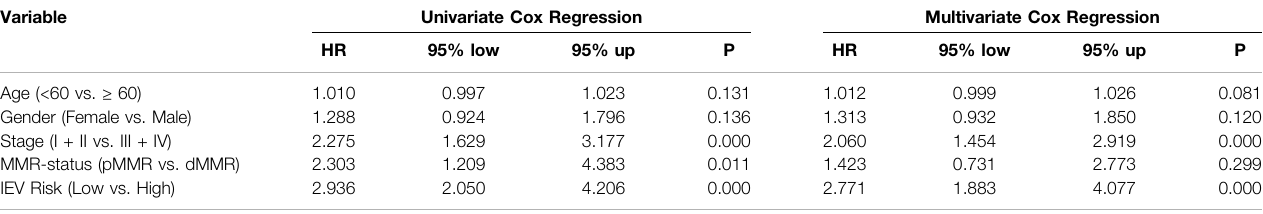
TABLE 1 | Univariate and multivariate Cox regression analysis in the GSE39582 cohort. Variable